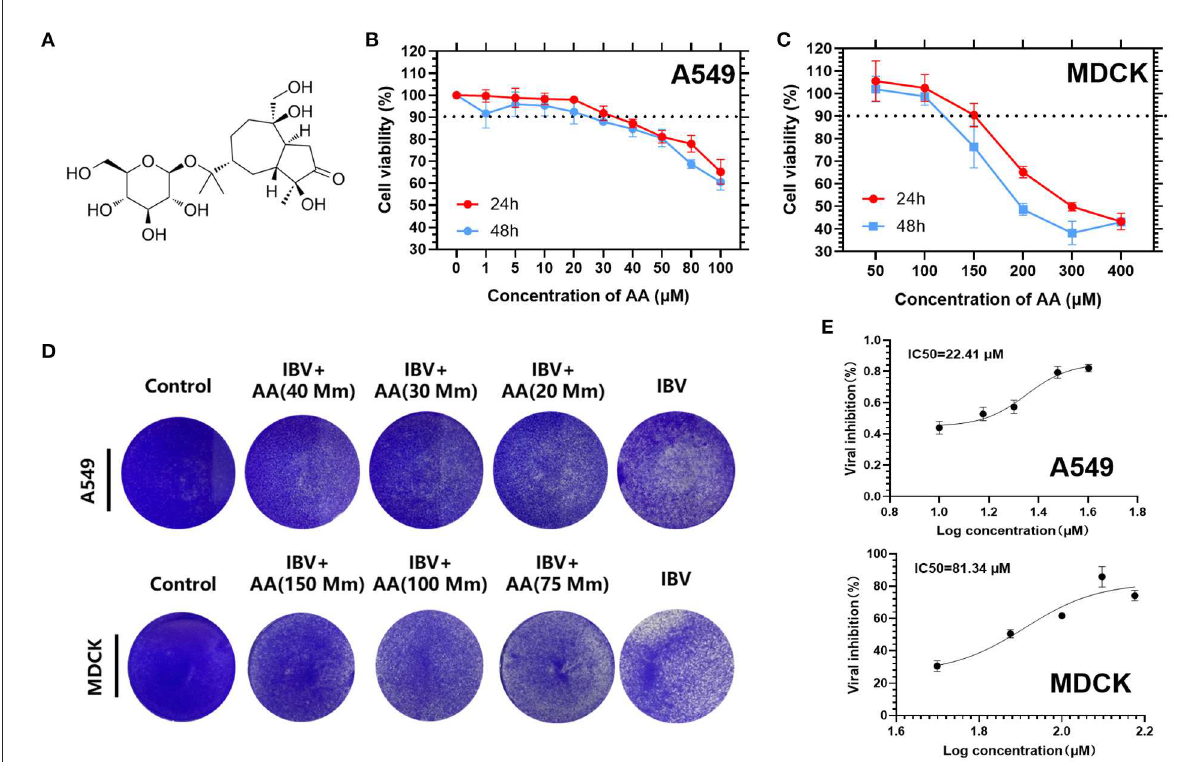
FIGURE1 Cell viability of Atractyloside A on MDCK and A549 cells. (A) Chemical structure of Atractyloside A. Cell viability of Atractyloside A on A549 (B) and MDCK (C) cells. (D) Crystal violet staining of MDCK and A549 cells infected with IBV, or with Atractyloside A + IBV, or mock control. (E) Half maximal inhibitory concentration assay (IC 50